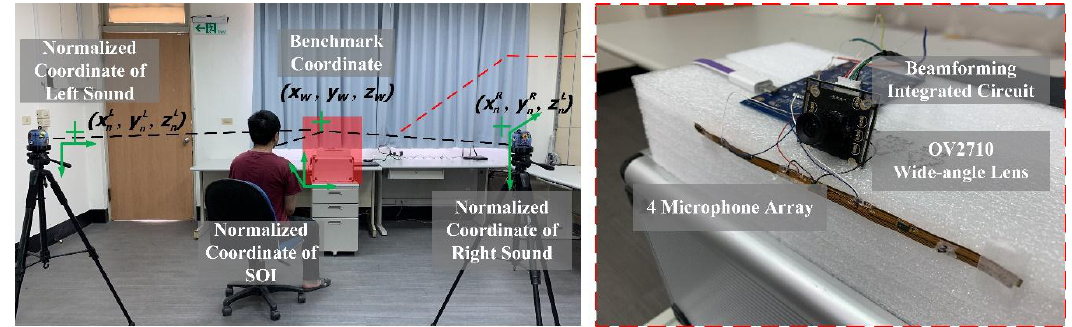
Figure 3. Three-dimensional positioning by using stereo triangulation. Virtual noise and SOI are needed to position arbitrary points in three dimensions.